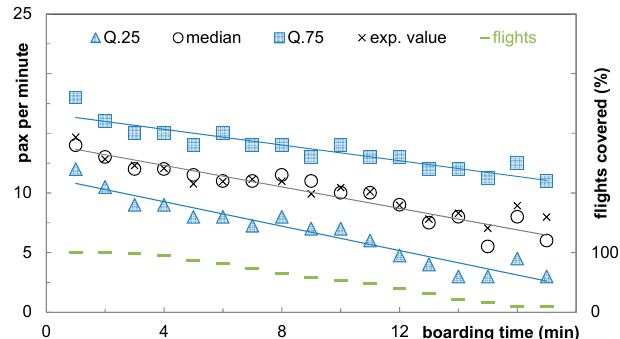
Figure 7. Passenger arrival rates decrease during aircraft boarding (arrival at aircraft door or at corresponding queue). Coverage of flights (green dashes) is indicated on secondary y -axis.